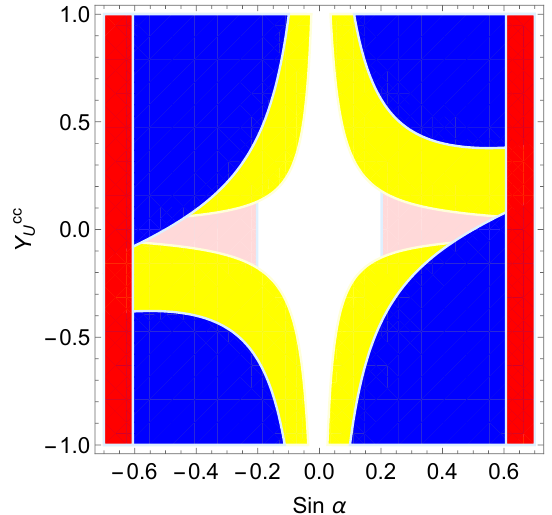
Figure 19. The excluded parameter space in the plane of Y cc dark red regions are the excluded regions from the LHC run-1 ggh coupling and WWh coupling measurements respectively. The light red regions are the predicted exclusion regions from the WWh coupling measurements at the 14 TeV LHC with 300 fb (cid:0) 1 luminosity. The yellow region is the cch coupling bounds taken from [43].